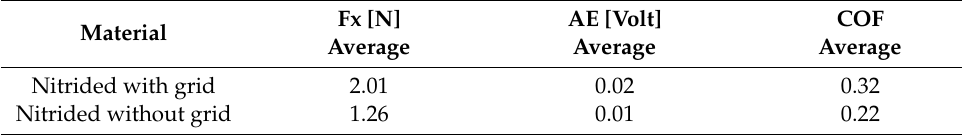
Table 9. Experimental result for the scratch